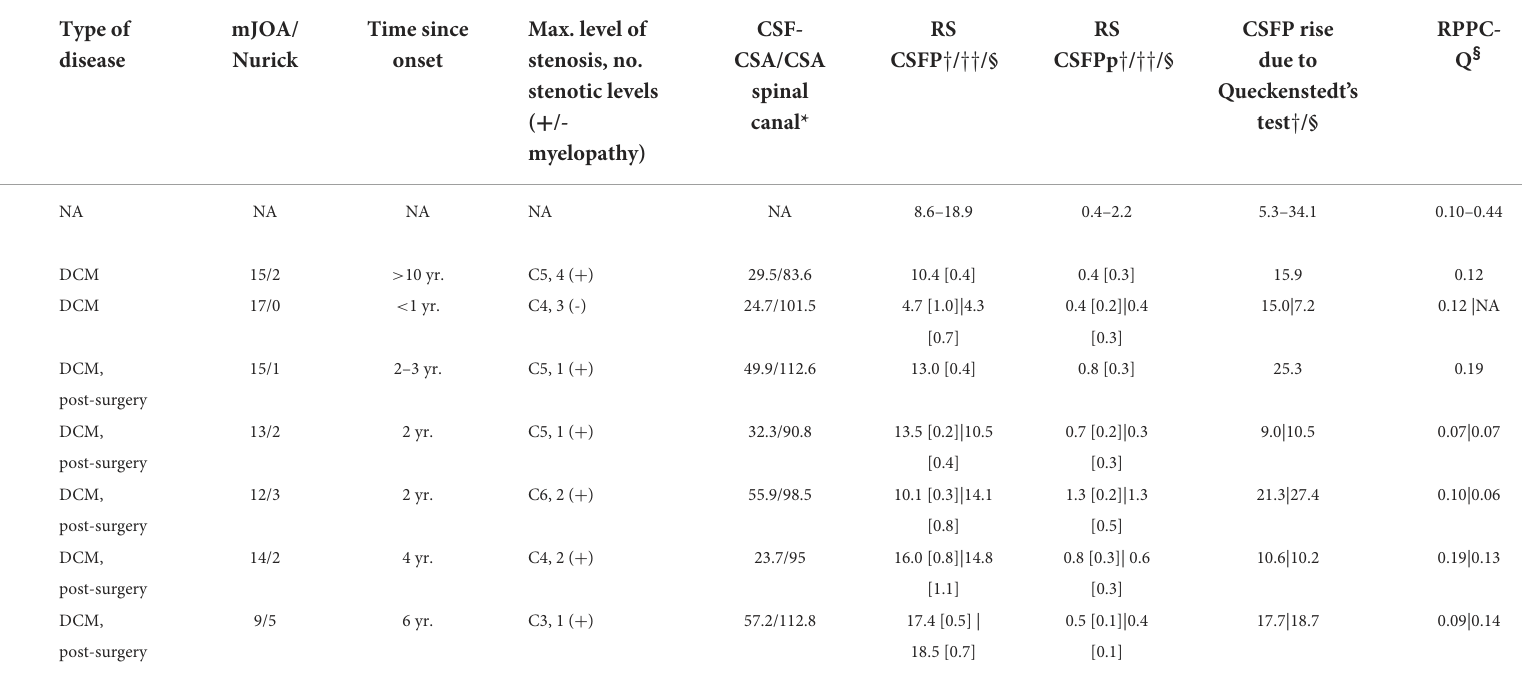
TABLE 1 Clinical characteristics and detailed CSFP findings of patients with degenerative cervical myelopathy